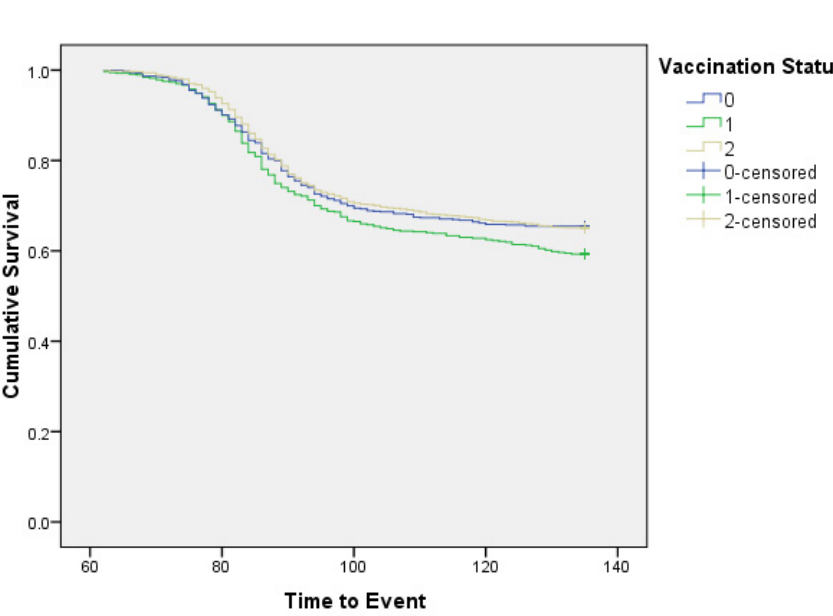
Figure 2. Kaplan–Meier curve showing time to occurrence of event (COVID-19) in ‘1’-dose vaccinated, ‘2‘-dose vaccinated, and unvaccinated groups (as per Strategy B). Analysis period: 16 March 2021 to 31 May 2021. Table 2. Regression analyses to determine tentative risk factors for occurrence and severity of COVID-19 during the second wave of pandemic between 16 March and 31 May 2021.